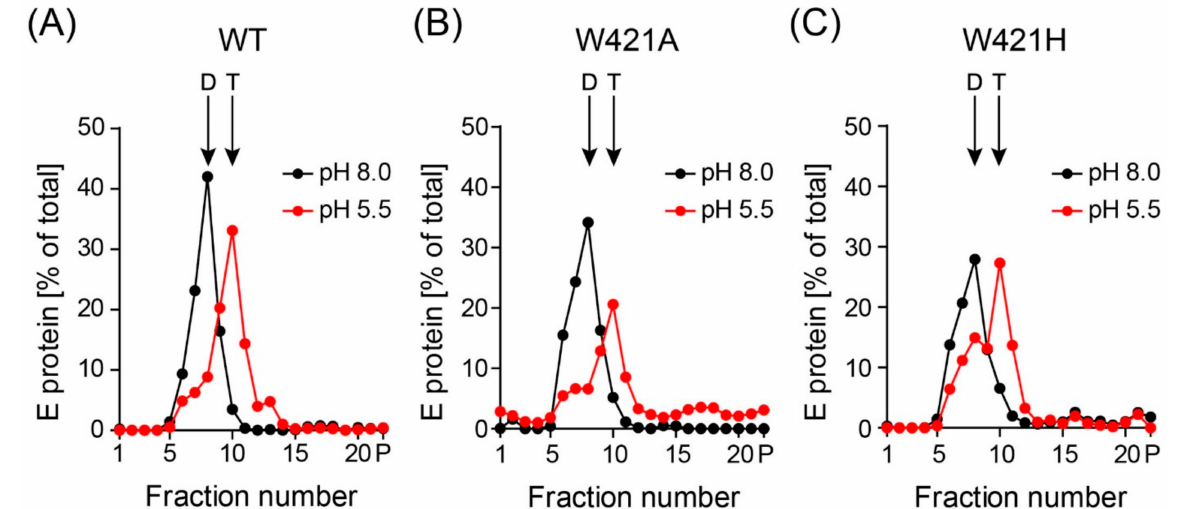
Figure 5. Sedimentation analysis of detergent-solubilized WT and mutant recombinant subviral particles (SVPs) after incubation at low pH. SVPs were incubated at pH 5.5 and pH 8.0. After back-neutralization, samples were solubilized and subjected to 7% to 20% sucrose density gradient centrifugation. The amount of E in each fraction was determined by a quantitative ELISA. Sedimentation direction is from left to right. Representative examples form three independent experiments are shown. ( A ) wildtype (WT), ( B ) W421A mutant, ( C ) W421H mutant. The position of E dimers (D) and trimers (T) are indicated by arrows.